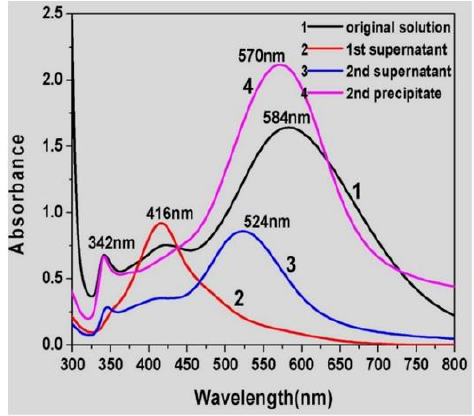
Figure 7. Separation of AgNPs by shape, monitored by UV–Vis spectrophotometry, after two se- quences of selective precipitation. Reprinted from [54] , copyright (2018), with permission from Else- of selective precipitation. Reprinted from [54], copyright (2018), with permission from vier.